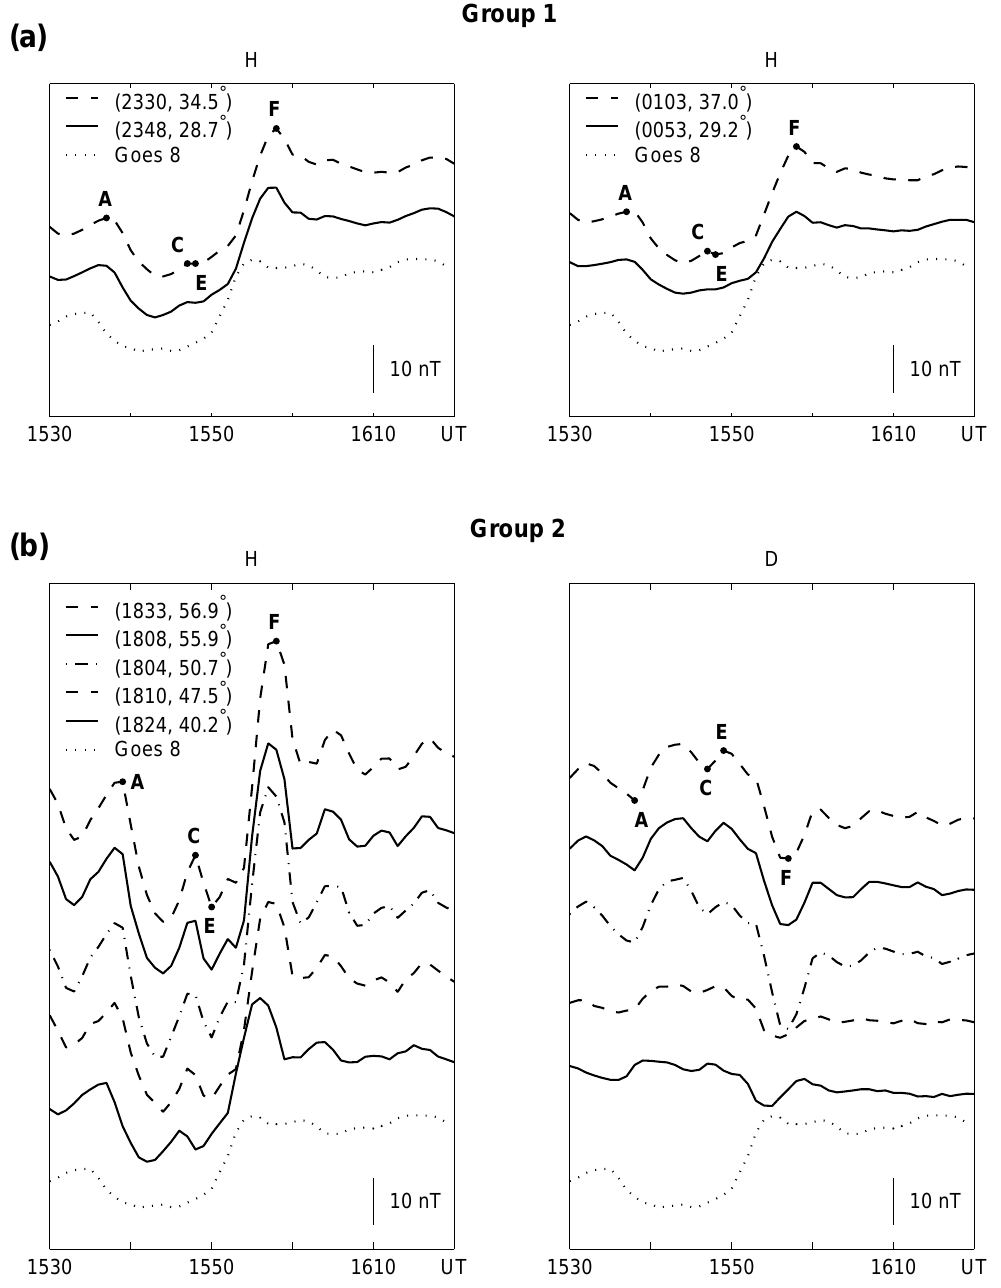
Fig. 3. ( a ) The magnetic field observations ( H component) for two different MLT sectors in group 1. ( b ) The magnetic field observations for a single MLT strip in group 2. Left plot: H component, right plot: D component. In the bottom trace of each panel the magnetospheric field from Goes